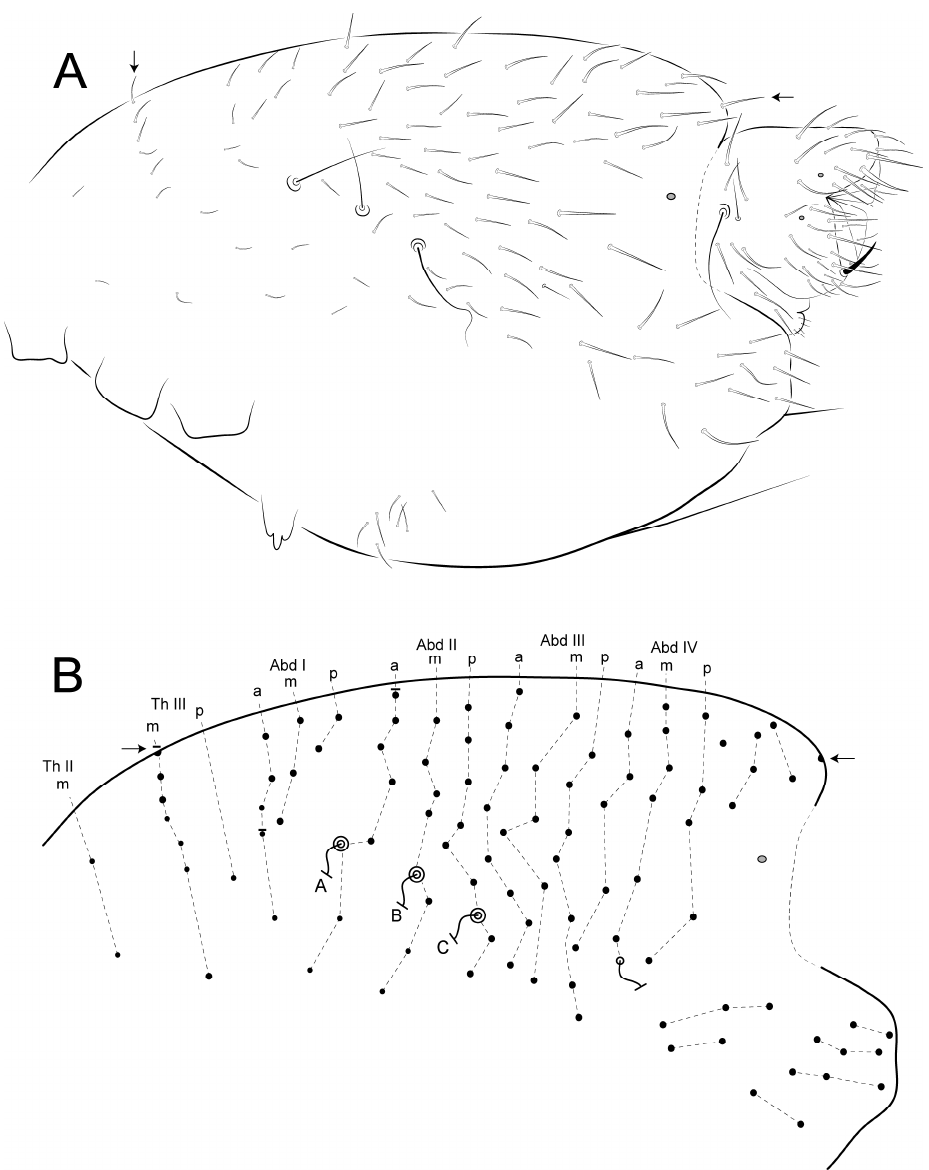
Figure 11. Arlesminthurus caatinguensis sp. nov. female, large and small abdomens (lateral view): ( A ) chaetotaxy as observed; ( B ) schematic representation of the large abdomen; arrows on both figures show unpaired chaetae.